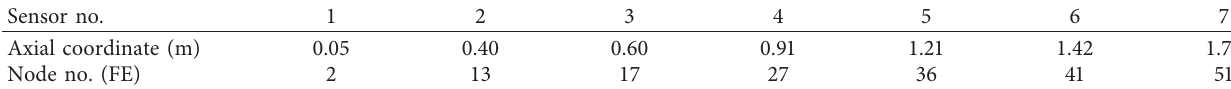
Table 1: Axial location of the accelerometer.